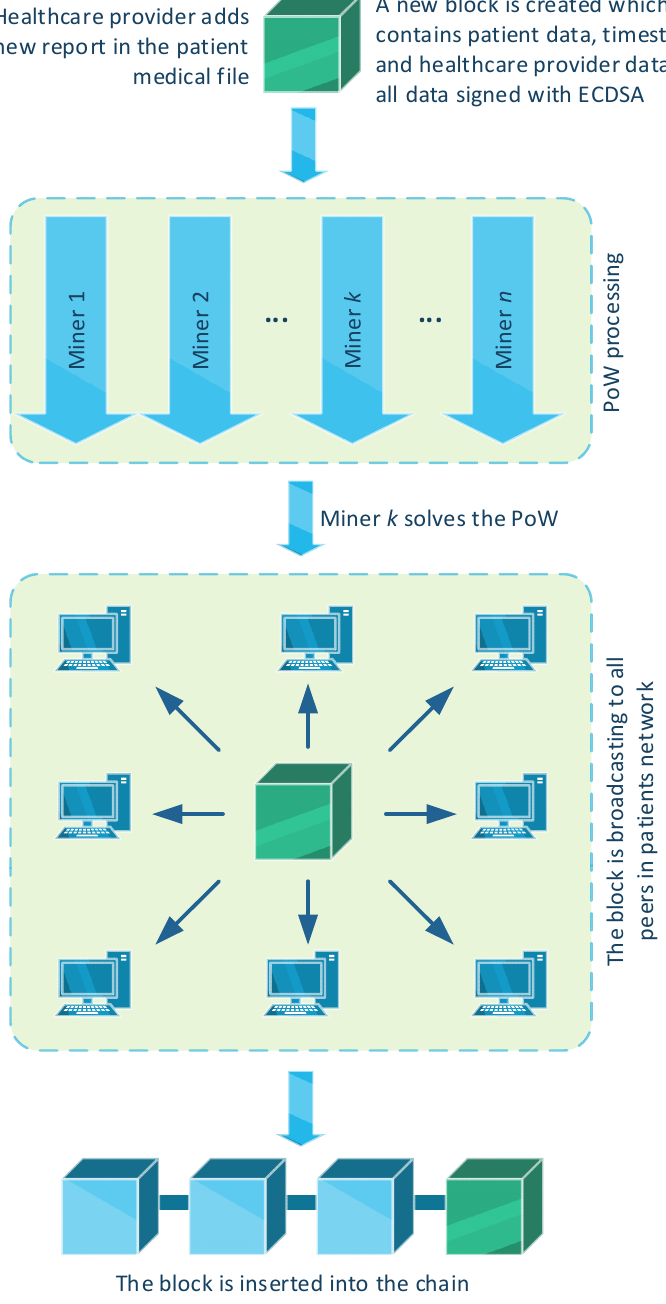
Figure 3. The PoW consensus protocol in the proposed BIoMT